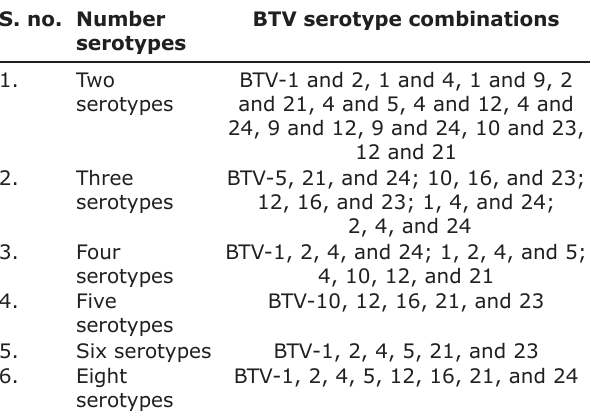
Table-2: Number and types of mixed serotype seroprevalences observed in Telangana state, India, during